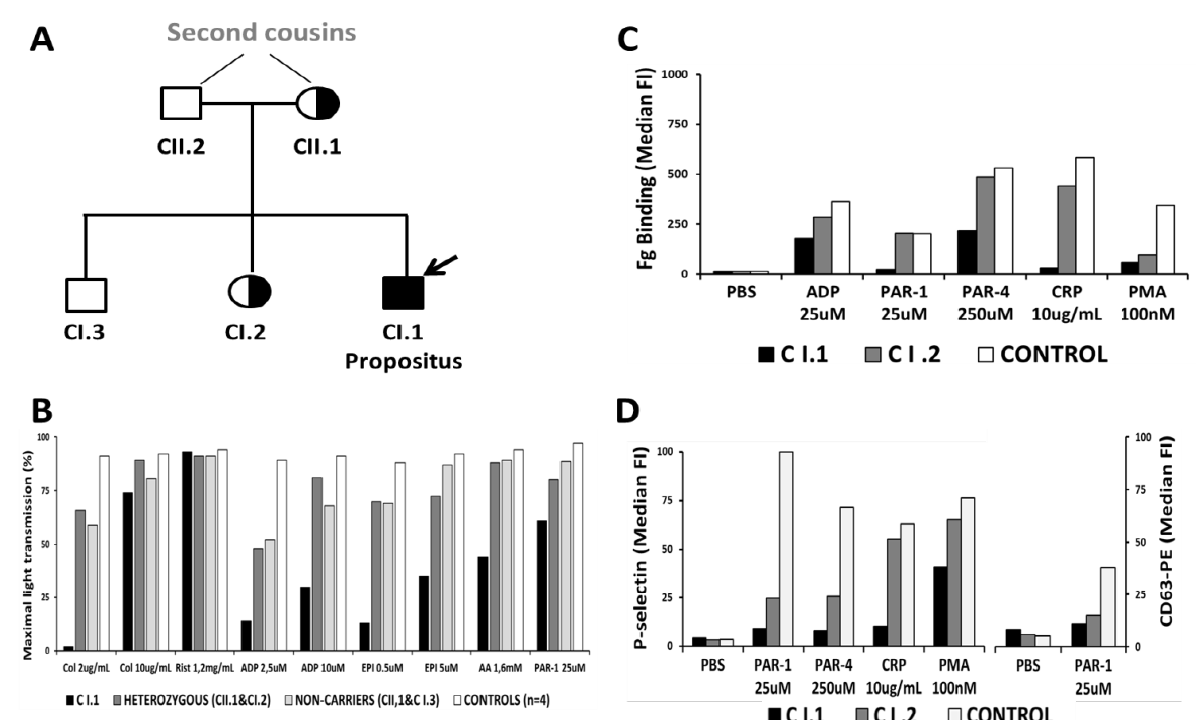
Figure 2. Family tree and platelet phenotyping of the Spanish pedigree C. In panel ( A ), black filled and half-filled symbols indicate hemizygosity and heterozygosity for the GATA1 p.H289Y variant, respectively. Panel ( B ) shows representative maximal platelet aggregation response in the hemizygous patient and mean aggregation values in his heterozygous and non-carrier relatives and in unrelated controls A similar aggregation defect has been observed several times in the patient over 30 years of follow-up. Panels ( C , D ) display agonist-induced α IIb β 3 and α - (P-selectin or CD62) and δ -granule (CD63) secretion in platelets from the patient, his healthy heterozygous sister, and a healthy unrelated control. Bars correspond to median fluorescence intensity (FI) values.